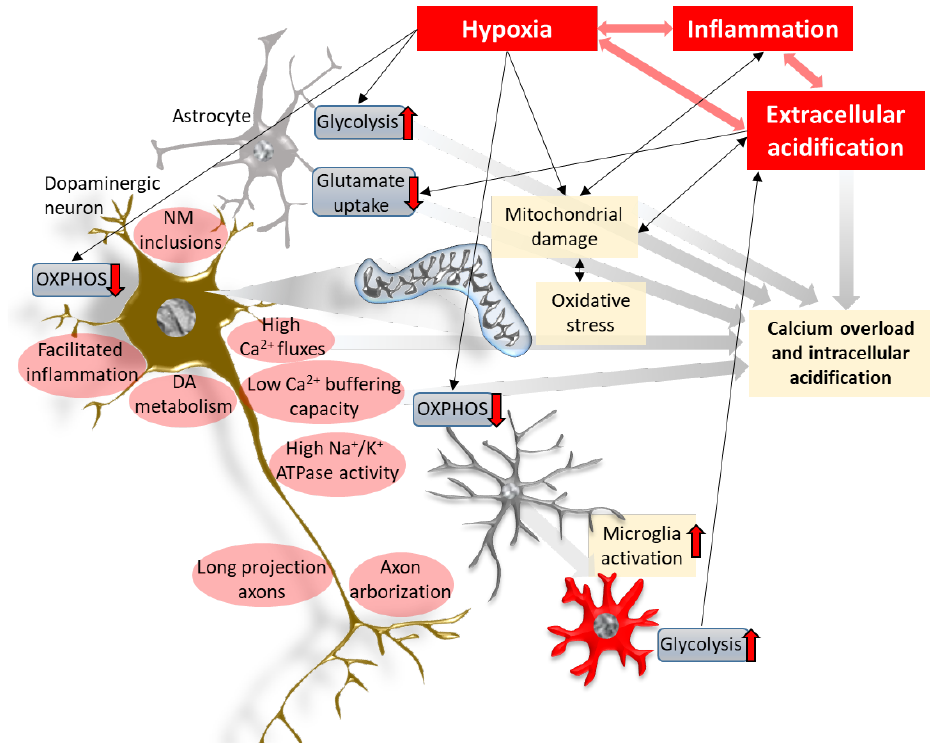
Figure 1. Hypoxia, acidification and inflammation in the center of the neurodegenerative process. Hypoxic insults in the brain induce shifts in energy metabolism that may lead to oxidative stress and mitochondrial damage, inducing pro-inflammatory signaling. Linked with the activation of glial cells, this results in neuroinflammation. Metabolic changes—strongly mediated by hypoxia inducible factors—of the different cell types lead to acidification of the cellular milieu, in part via the accumulation of lactate and other metabolites. Extracellular acidification increases the activity of cation-permeable acid-sensing ion channels and, in conjunction with impaired mitochondrial proton transport, this results in disturbances of the intracellular ion homeostasis, yielding acidification and Ca 2+ toxicity. Together with associated mitochondrial damage, oxidative stress and inflammation, they are prominent mechanisms leading to neurodegeneration. The cell-autonomous features of dopaminergic projection neurons in the substantia nigra pars compacta (red ellipses) likely exacerbate the detrimental effects of such cellular environments. NM: neuromelanin, OXPHOS: oxidative phosphorylation.